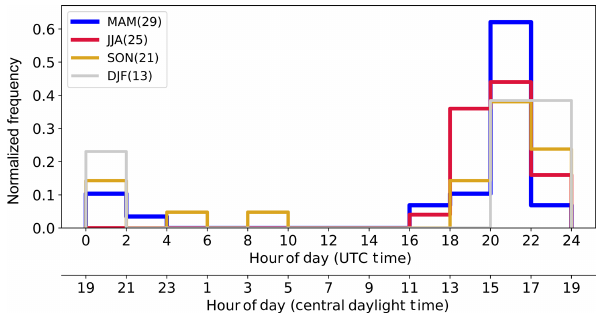
Figure 6. Normalized frequency of the daily time of peak concen- trations associated with the 24h cycle in N T . This figure only in- cludes weekly data chunks that had normalized power associated with the 24h cycle greater than that of the corresponding seasonal estimate of the red noise spectrum power. The numbers in paren- theses represent the number of weekly data chunks that met this